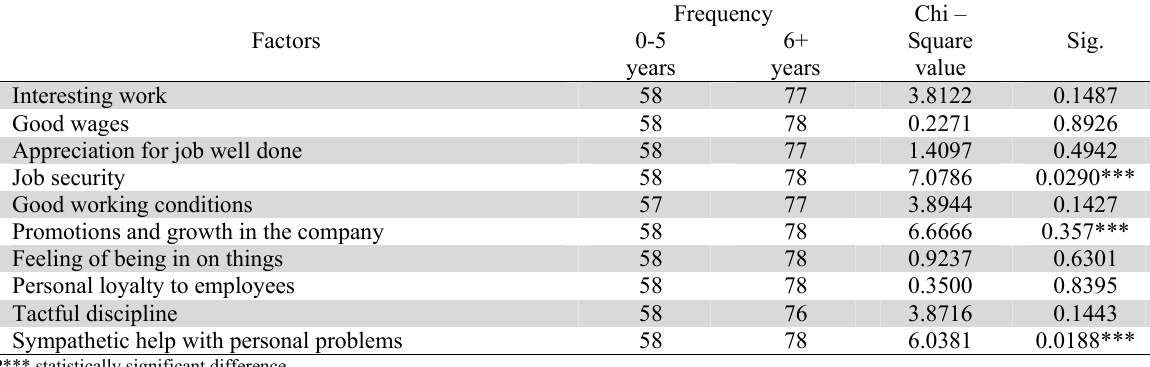
Chi-square test for Education level as the independent variable